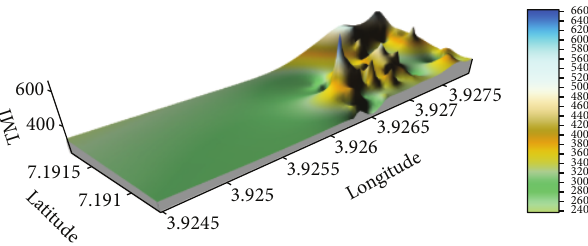
Figure 7: Profile 2.